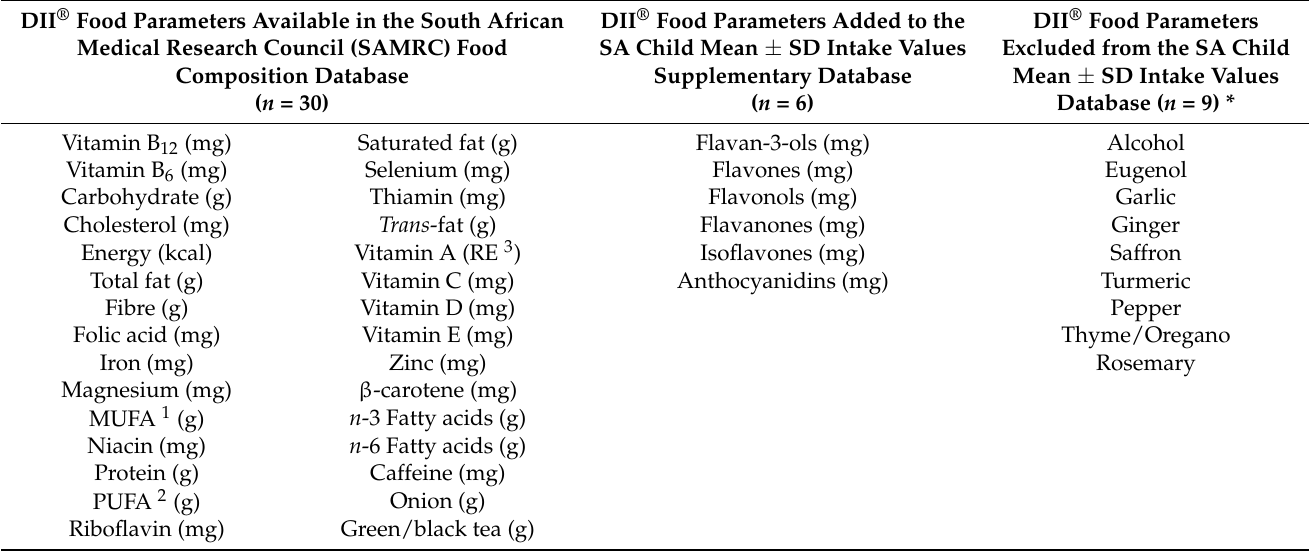
Table 2. Available, additional, and excluded food parameters used to develop the mean ± SD intake values for South African children, based on the 45 food parameters included in the original DII ®